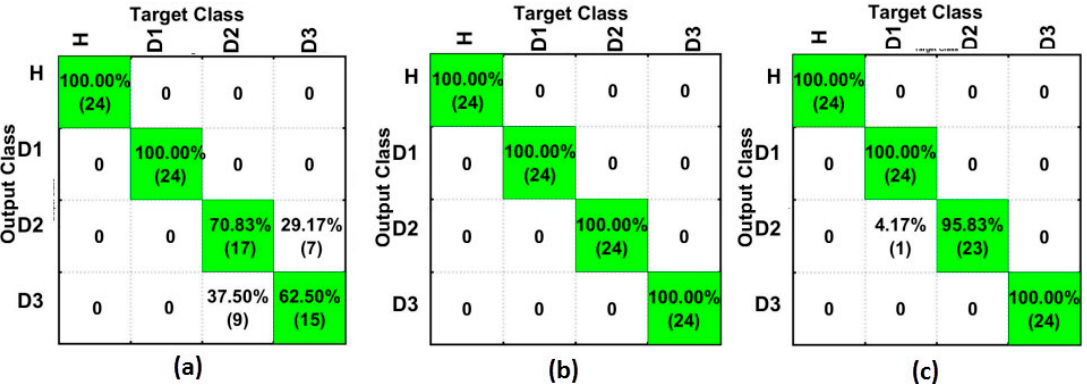
Figure 10. Results for the SFAN-based method (time domain) considering only Savitzky–Golay (SG)